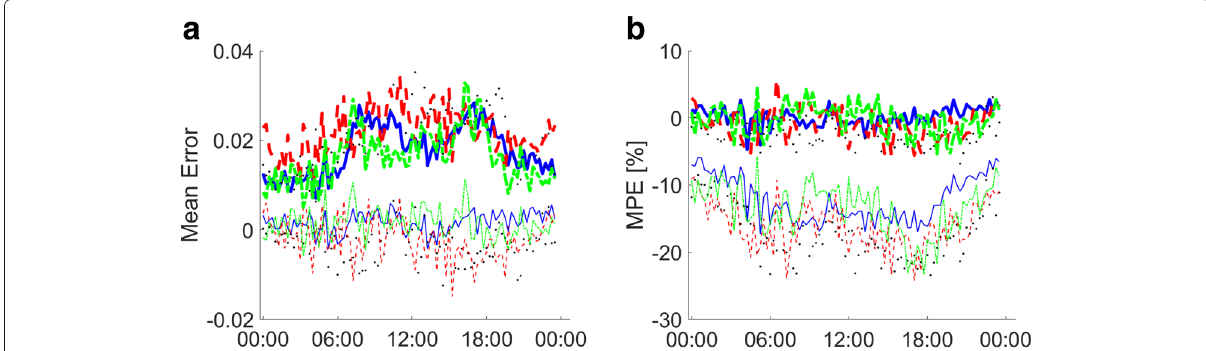
Fig. 6 Average mean error (ME) and mean percentage error (MPE) for the validation sample averaged over links. a ME, b MPE. Hietzing (blue), Westbahnhof (black, dotted), Ring (red, dashed), Südosttangente (green, dash-dotted). Results for the indirect method in bold, results for the direct method in normal line width indirect method achieved better ME and better standard deviations.